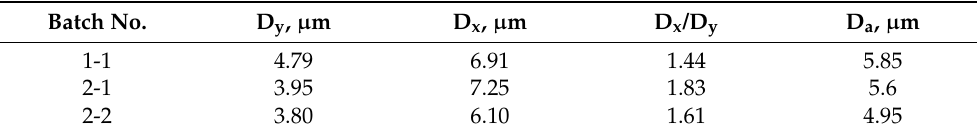
Table 4. Grain size in the test